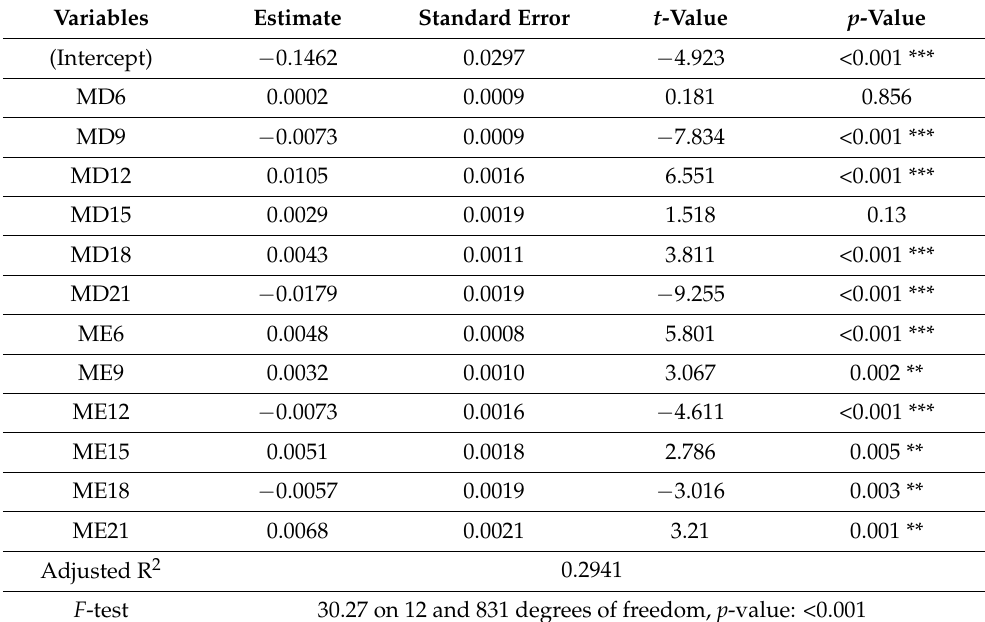
Table 2. Summary of the global linear regression